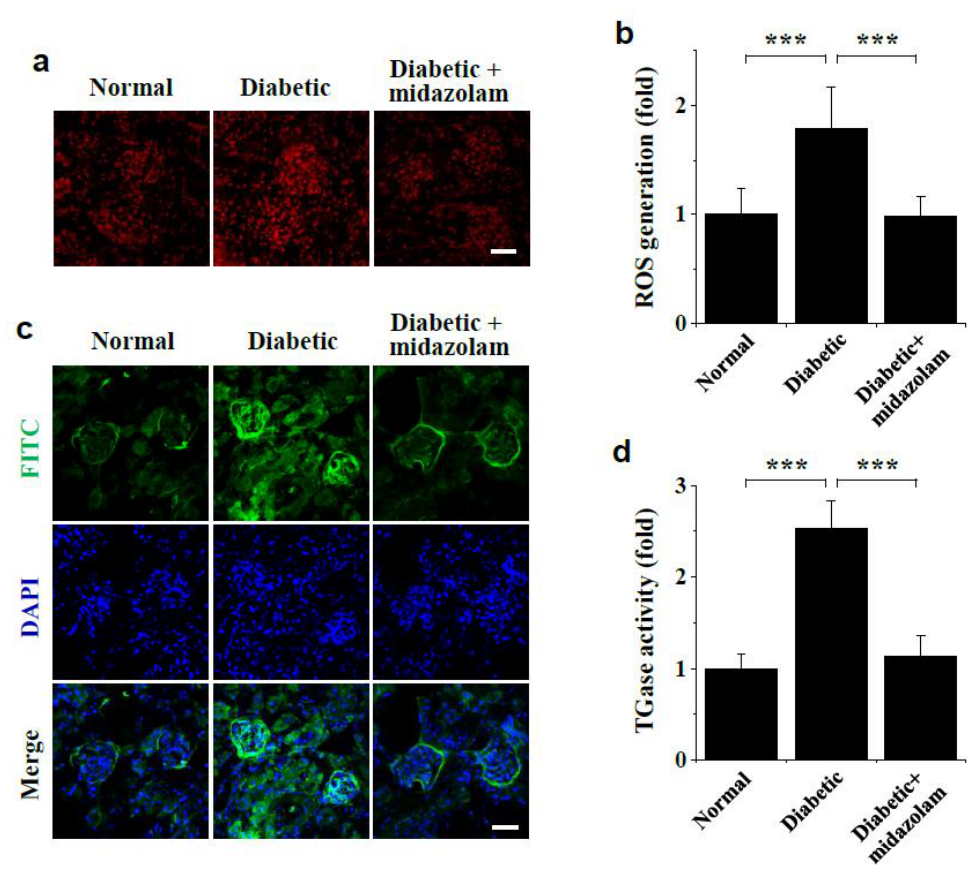
Figure 6. Midazolam treatment inhibits hyperglycemia-induced ROS generation and TGase activation in kidneys of diabetic mice. Diabetic mice were treated with midazolam by subcutaneous injection for 6 weeks, and both ROS generation ( a , b ) and in vivo TGase activity ( c , d ) were visualized and analyzed by confocal microscopy in kidneys from normal, diabetic, and midazolam-treated diabetic mice ( n = 8). ( a ): Representative fluorescence images to measure ROS generation in kidney glomeruli. Scale bar, 50 µ m. ( b ): ROS levels were quantified by measuring fluorescence intensity in the renal glomerulus. ( c ): Representative fluorescence images of in vivo TGase activity (green) with DAPI (blue) nuclear counterstaining in kidney glomeruli. Scale bar, 50 µ m. ( d ): TGase activity was quantified by measuring fluorescence intensity in the renal glomerulus. Scale bar, 50 µ m. *** p < 0.001.